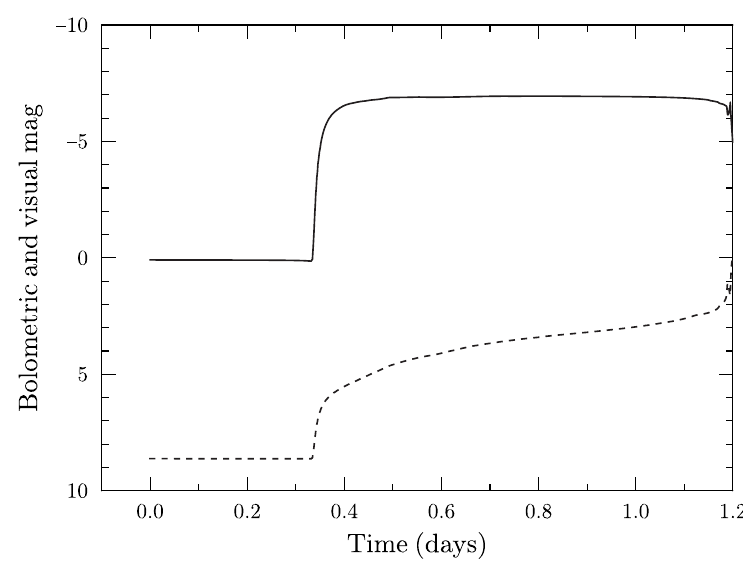
Fig. 10. The same as in Figure 7 but for 1.35 M ⊙